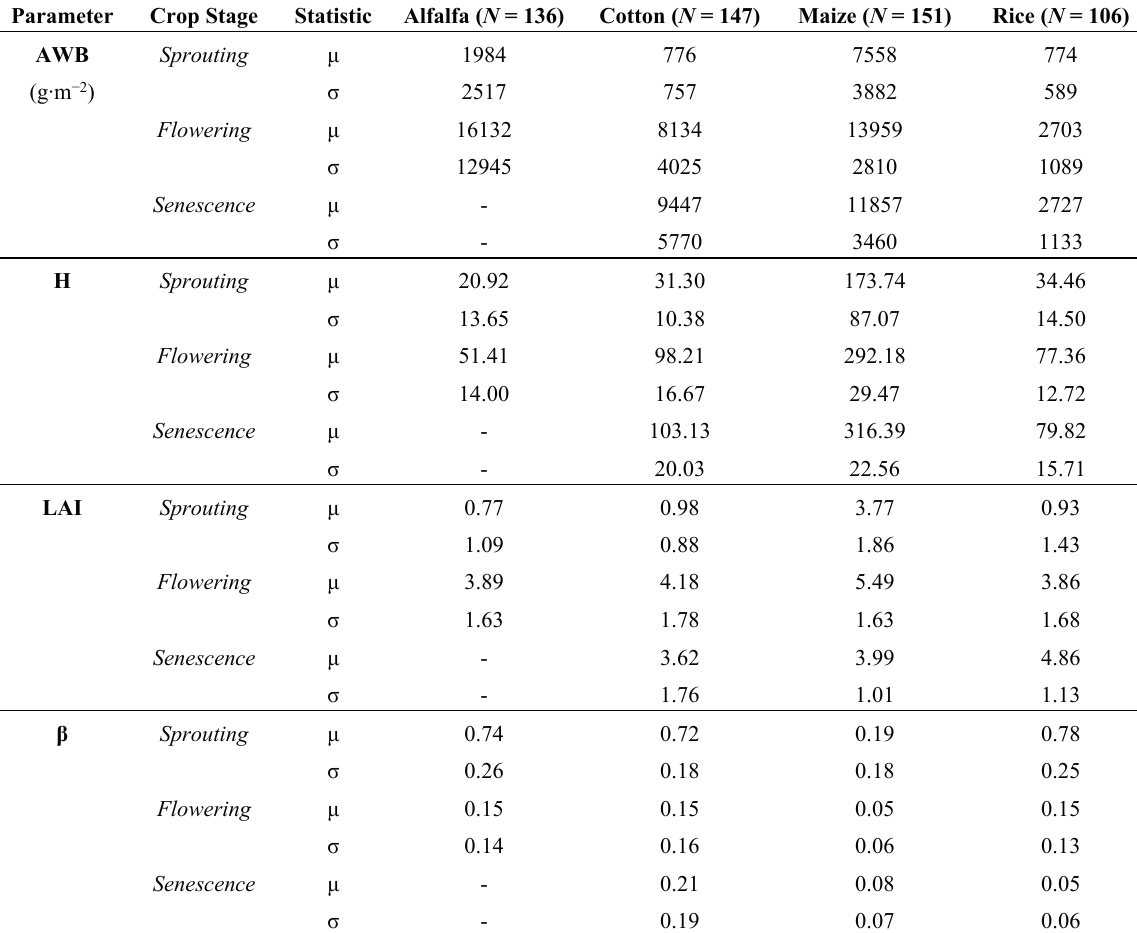
Table 1. Summary of statistics of alfalfa, cotton, maize, and rice AWB and non-spectral samples taken for each major phenological crop stage during the 2011 and 2012